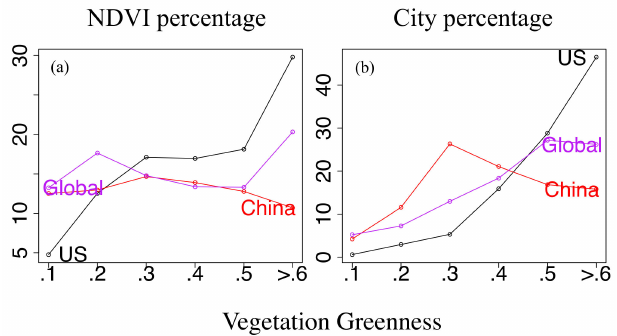
Figure 5. Statistics of ( a ) NDVI percentage (ratio of vegetation covered area ( T < NDVI < T + 0.1) / area), and ( b ) city percentage (fraction of vegetation cover in cities area ( T < NDVI < T + 0.1, light > 12) / area (light > 12)) depending on vegetation greenness for the Globe, China and